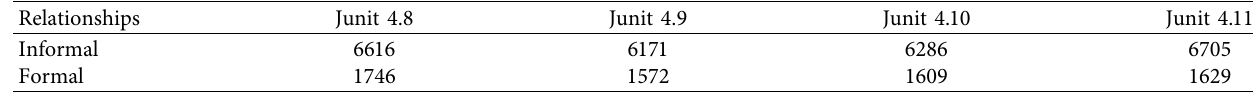
Table 16: Formal and informal relationships in Junit.